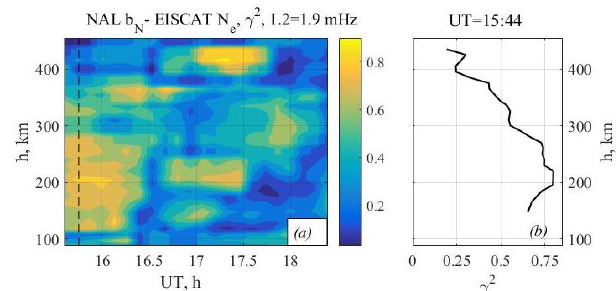
Figure 14. (a) Dynamic altitude distribution of spectral coherence between EISCAT N e and NAL b N in the 1.2–1.9mHz frequency band during the evening hours, (b) and the altitude distribution of spectral coherence for the 15:44